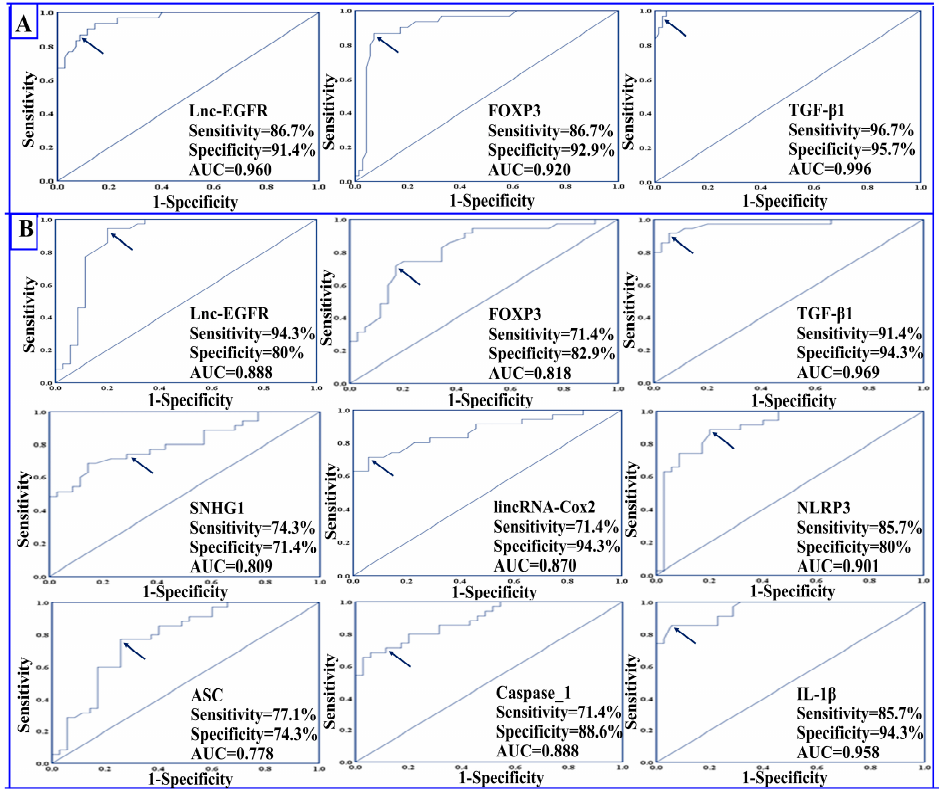
Figure 4. Receiver operating characteristic (ROC) curves showing ( A ) the diagnostic power of lnc- EGFR, FOXP3, and TGF- β 1 in differentiating RRMS patients (n = 70) from healthy controls (n = 30) and ( B ) the prognostic power of all the studied biomarkers in differentiating RRMS patients during relapse (n = 35) from patients in remission (n = 35). The arrow denotes the best cutoff point.